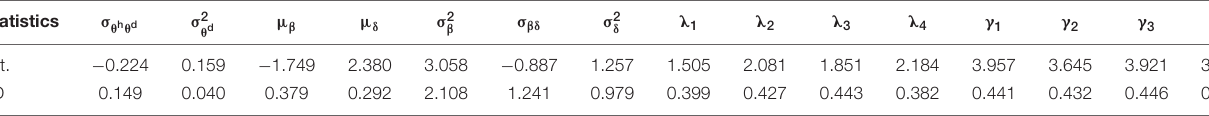
TABLE 8 | Estimates and standard errors of the parameters for the real data.